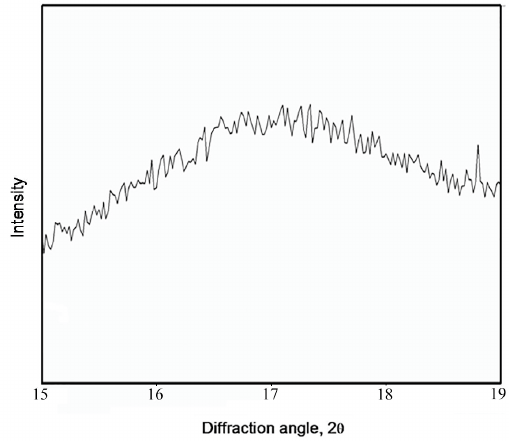
Figure 9. X-ray di ff raction pattern of the deformed sample ( e = 6.4), (Mo K α Figure 9. X-ray diffraction pattern of the deformed sample ( e = 6.4), ( М o K α ).